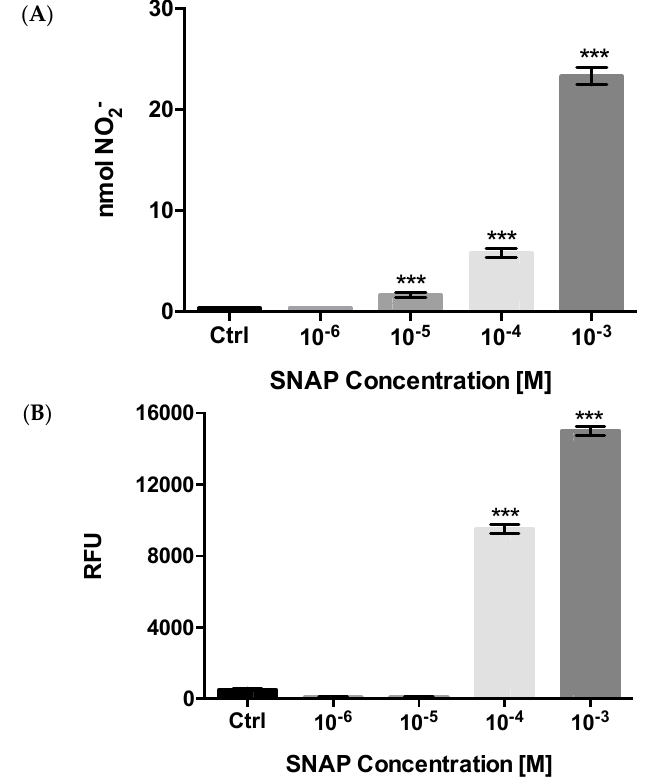
Figure 6. NO concentration at extracellular and intracellular level in EA.hy926 cells treated with SNAP. EA.hy926 cells were treated with SNAP 10 − 6 –10 − 3 M for 2 h. Then, NO was quantified in the extracellular medium by Griess test ( A ) or at intracellular level by the fluorescent dye DAF-2 DA and expressed as Relative Fluorescence Units (RFU); ( B ) Data are the mean ± S.E.M. of five samples per